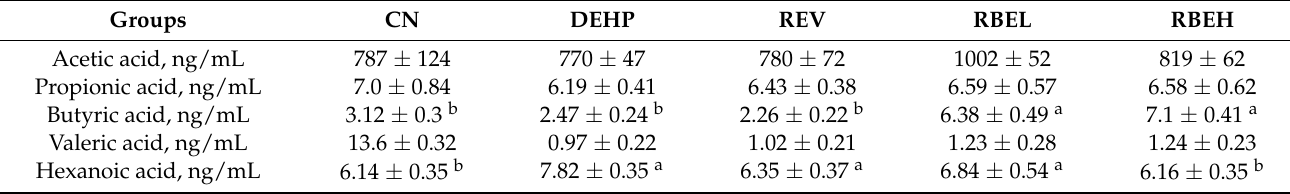
Table 3. Plasma concentrations of SCFAs of male offspring at 12 weeks of age.